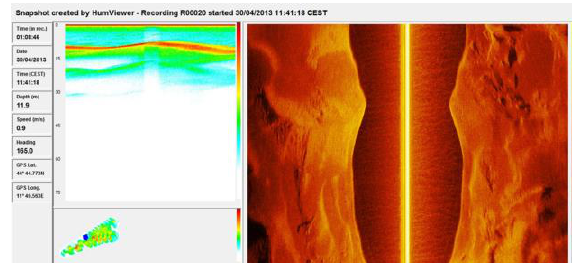
Figure 10. Gambulaga – Portomaggiore (FE), Tramonto Lake, snapshot with scattered Roman Bricks.